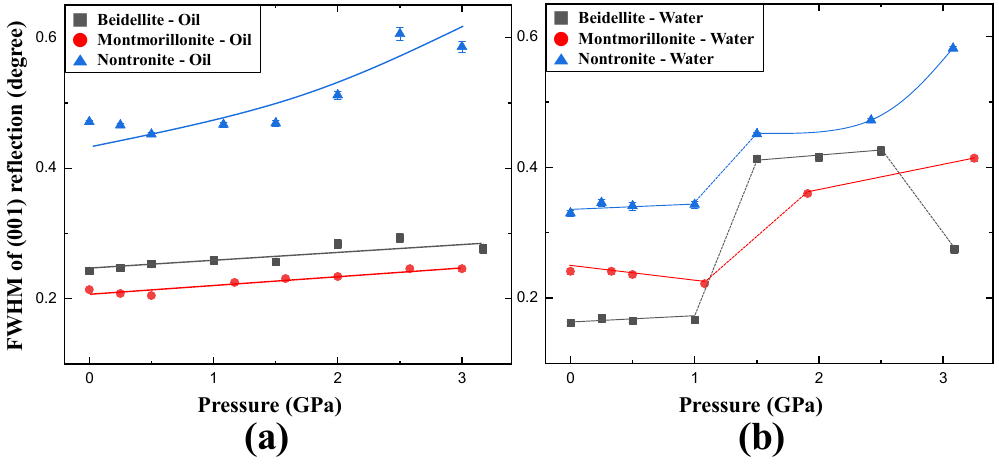
Figure 5. Pressure-dependent FWHM changes of the interplane (001) Bragg reflections of beidellite, montmorillonite, and nontronite under ( a ) anhydrous and ( b ) hydrous environments, respectively. Unit-cell volumes of montmorillonite (Ca 0.3 (Al, Mg) 2 (Si 4 O 10 )(OH) 2 · nH 2 O) and nontronite (Ca 0.5 Fe 4 (Si, Al) 4 O 10 (OH) 2 · nH 2 O) in silicone oil PTM gradually decreased with contraction of